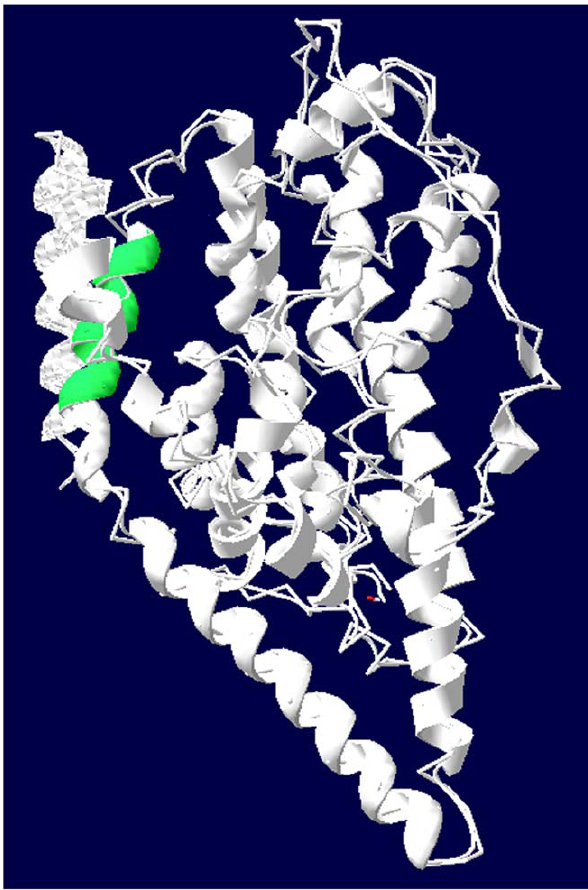
Figure 1. Structural model of Glt ph . The figure was prepared with the SPDB Viewer using the coordinates from PDB code 1XFH. The end of the TM5, from position 291 to 300, is colored green.